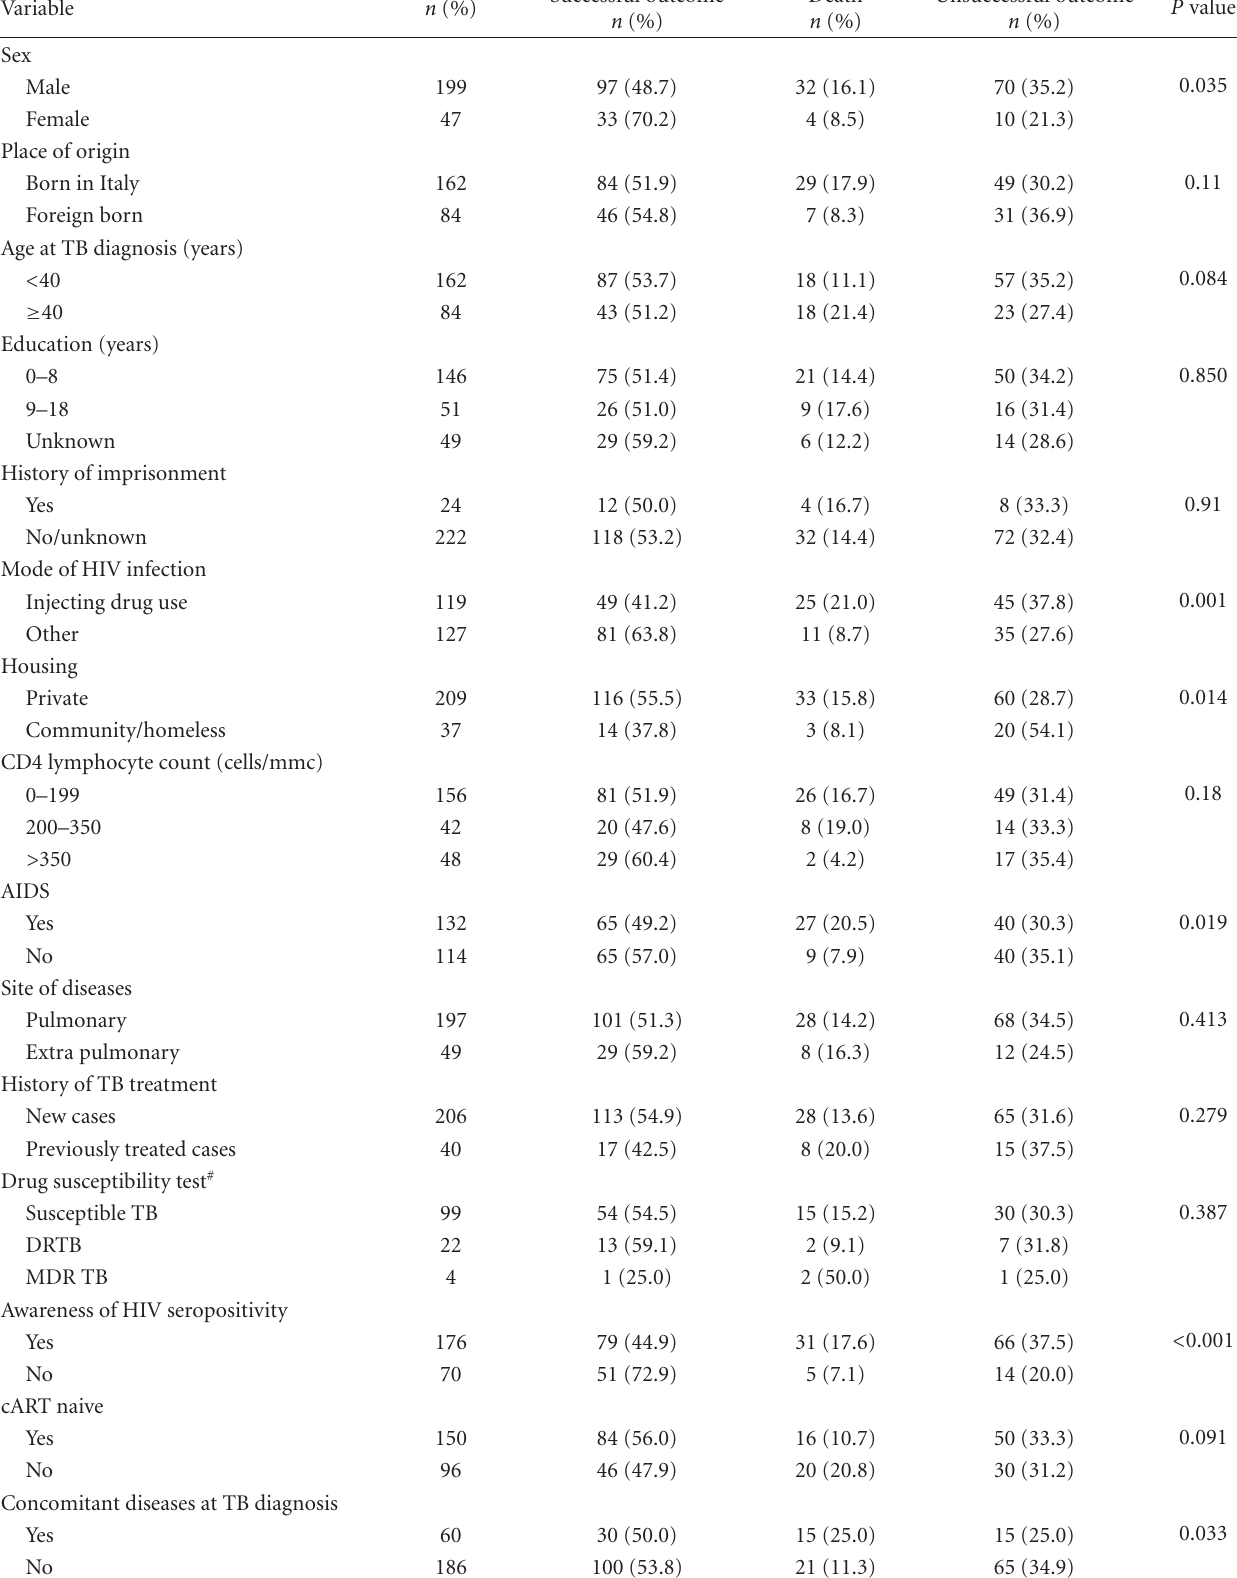
Table 1: Characteristics of 246 HIV-infected patients at tuberculosis diagnosis and outcome of